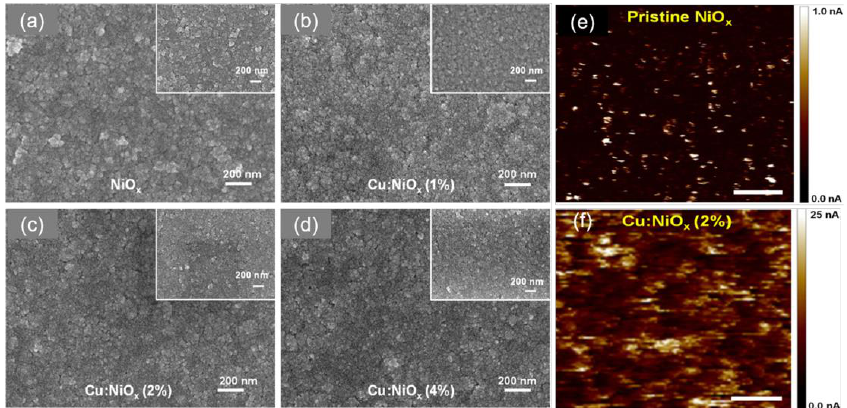
Figure 5. SEM images of ( a ) NiO x , ( b ) 1 mol.% Cu doped NiO x , ( c ) 2 mol.% Cu doped NiO x and ( d ) 4 mol.% Cu doped films deposited on flexible substrates (SEM images of corresponding films on rigid substrates are shown inset); AFM images of ( e ) NiO x and ( f ) 2 mol.% Cu doped NiO x films. Reproduced from [63], with permission from the ACS Applied Materials & Interfaces, 2017.